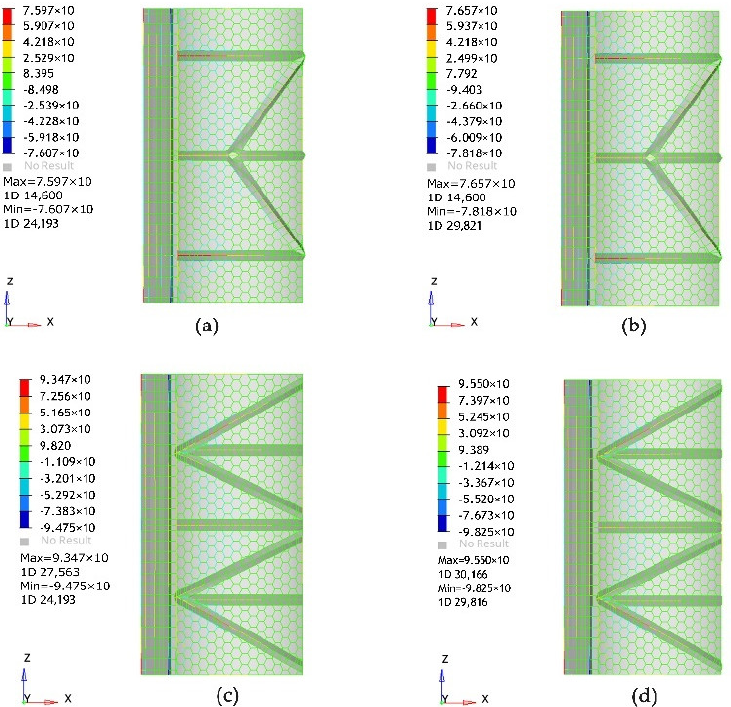
Figure 22. ( a ) Linear stress analysis of the carport I model under the G k + Q W load; ( b ) Nonlinear stress analysis of the carport I model under the G k + Q W load; ( c ) Linear stress analysis of the carport II model under the G k + Q W load; ( d ) Nonlinear stress analysis of the carport II model under the G k + Q W load.